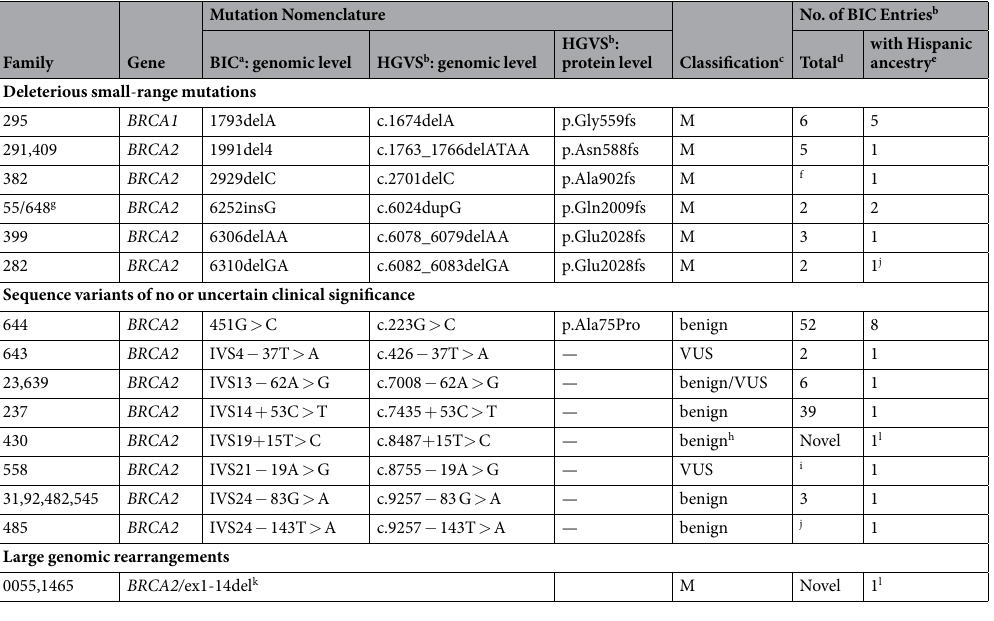
Table 2. Small-range mutations and large genomic rearrangements in the BRCA1/2 genes in Colombian breast/ovarian cancer families. a BIC, Breast Cancer Information Core database as of October 2016 (https:// research.nhgri.nih.gov/bic/). b Nomenclature follows Human Genome Variation Society (HGVS) (https:// www.hgvs.org/). Numbering starts at the first A of the first coding ATG. (located in exon 2) of NCBI GenBank Accession NM_007294.3 ( BRCA1 ) and NM_000059.3 ( BRCA2 ). c M, deleterious mutation; VUS, variant of uncertain clinical significance. d Including those with ancestry data and those from the present study. e The term “Hispanic” was used for individuals of Spanish, Mexican, Central and South American, Cuban, or Puerto Rican descent. f Reported in one multiple case breast cancer family from Spain (in Miramar MD, et al . Genetic analysis of BRCA1 and BRCA2 in breast/ovarian cancer families. from Aragon (Spain). Breast Cancer Res Treat 2008;112(2):353-8, p353). g Two probands in family 55/648. h Classification based on in silico analyses. i Three times reported in NCBI. j Once reported in NCBI. k The deletion breakpoints were not determined. l Identified in the present